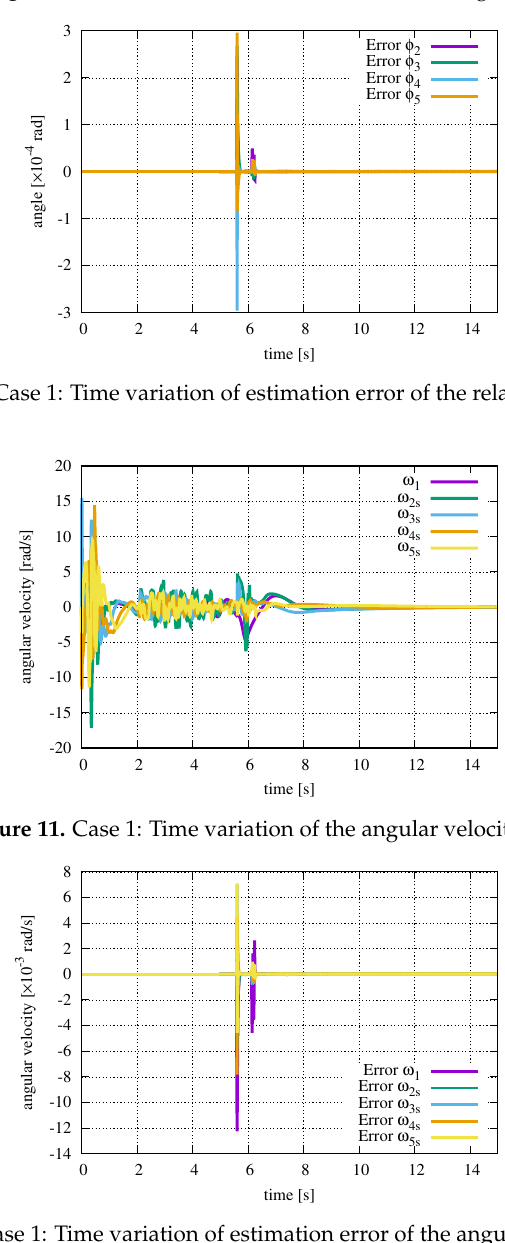
Figure 9. Case 1: Time variation of the relative angles.